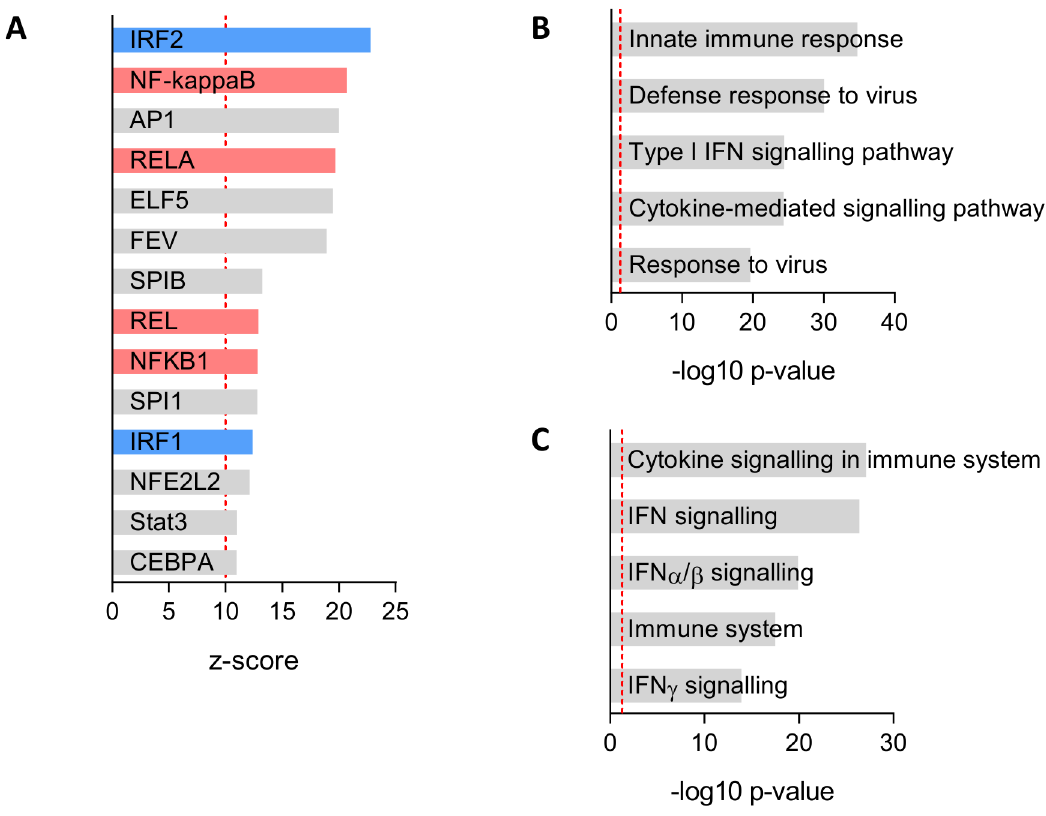
Fig 5. PBEC responses to Mtb-driven inflammation are enriched for pro-inflammatory and interferon-mediated signalling. All DE genes at a q-value < 5% were used for statistical over-representation analysis(ORA) by InnateDB and oPOSSUM. The most significant(A) Transcription Factor BindingSites (TFBS), (B) Pathways and (C) Gene ontology terms are shown. Red dashedline indicatesa z-score of 10 or a corrected p-value of 0.05. For (A), IRF- and NF κ B-family members are highlightedin blue and red